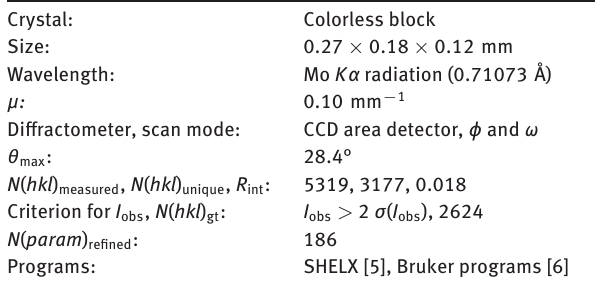
Table 1: Data collection and handling.